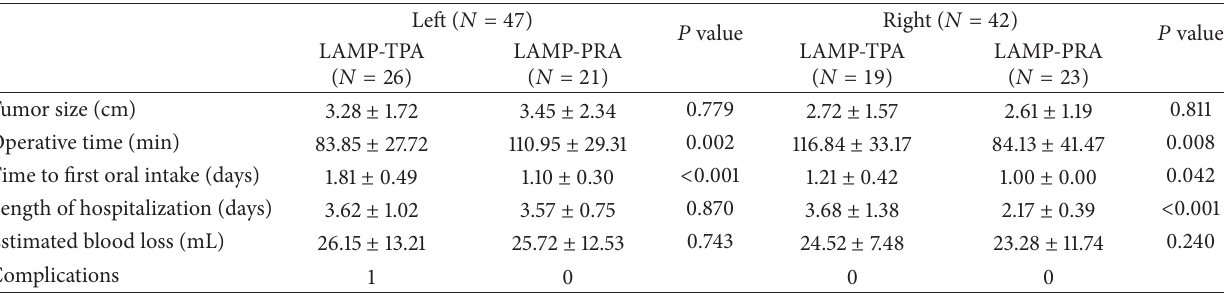
Table 2: Outcomes after